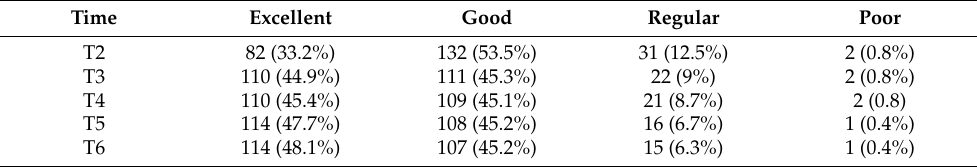
Table 4. Comparison of the MacNab scale according to the periods 1 month (T2), 3 months (T3), 6 months (T4), 12 months (T5), and 24 months (T6)